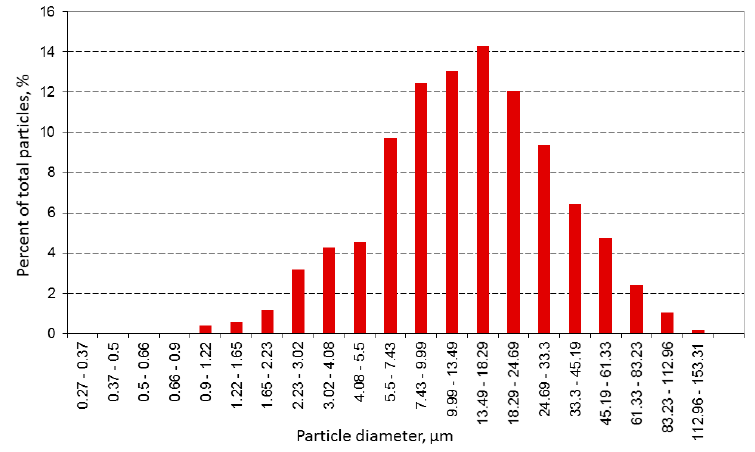
Figure 3. Particle size distribution of Re-Ni alloy powder: Thermal reduction at 800 °C for 1 h.